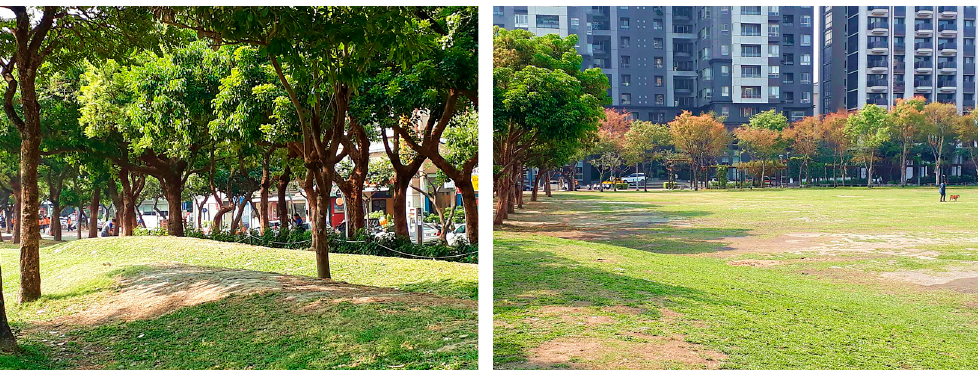
Figure 1. Taichung Greenways.